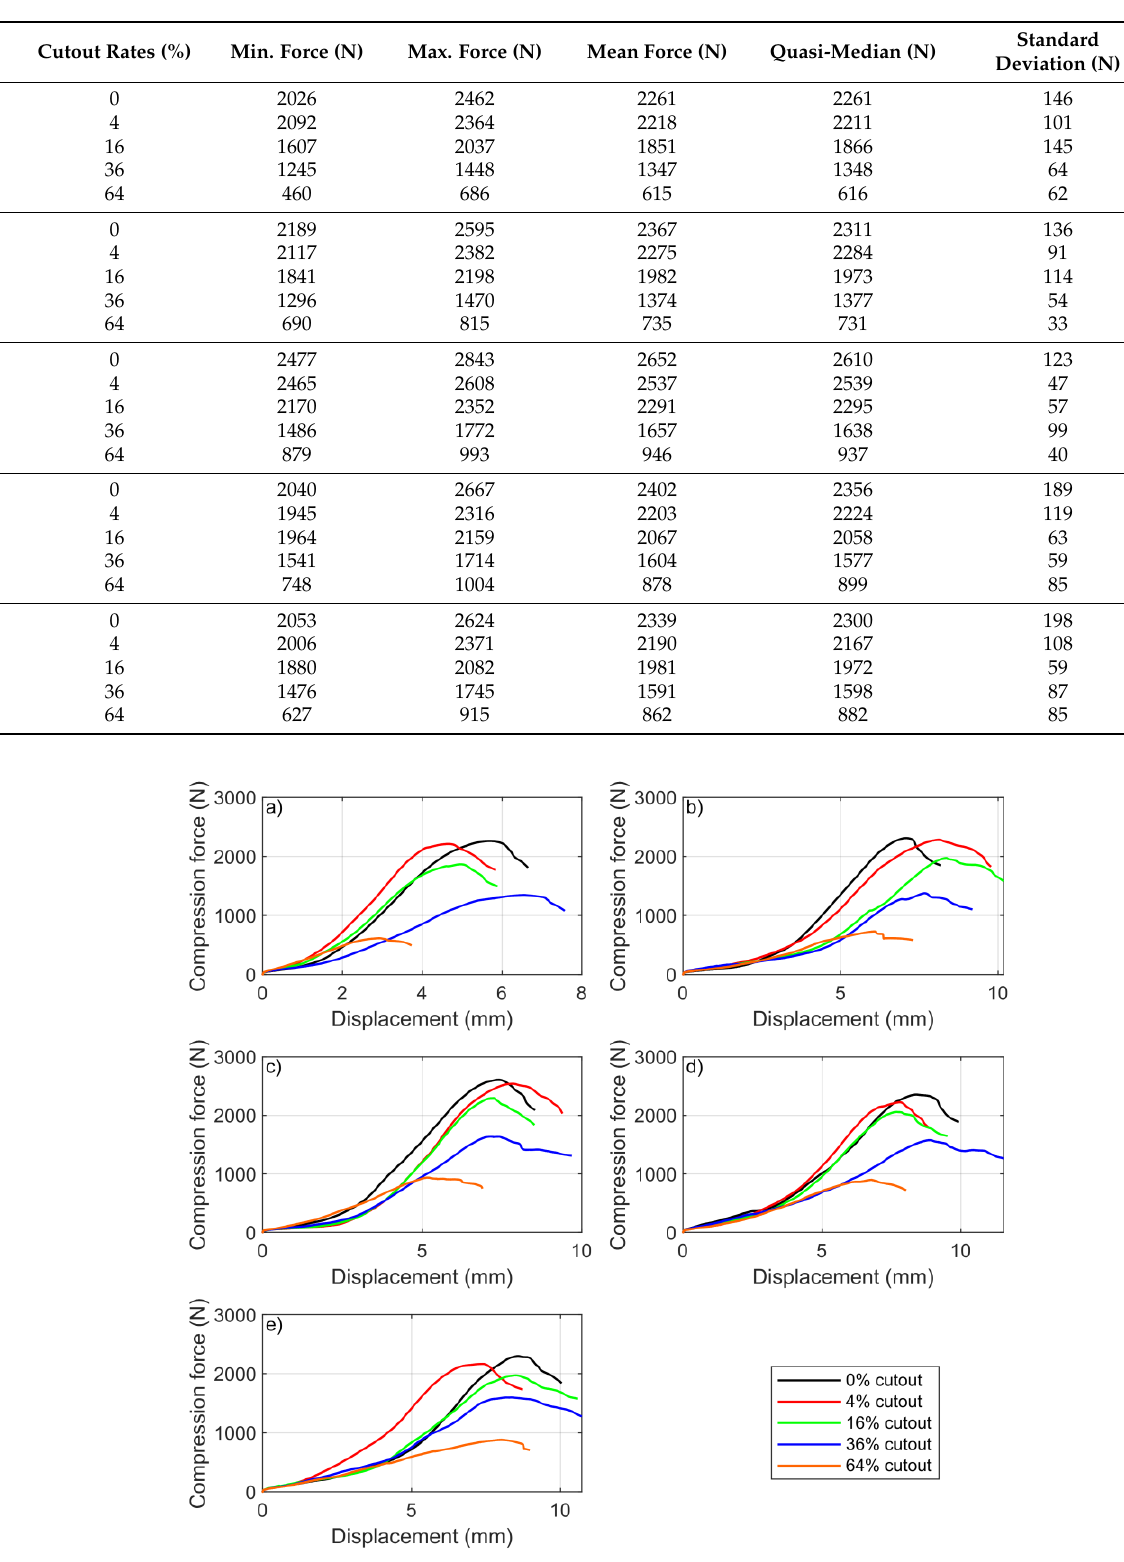
Figure 5. BCT quasi-median values: ( a ) 600 × 300 × 300 mm box, ( b ) 500 × 300 × 300 mm box, ( c ) 400 × 300 × 300 mm box, ( d ) 300 × 300 × 300 mm box, and ( e ) 200 × 300 × 300 mm box.